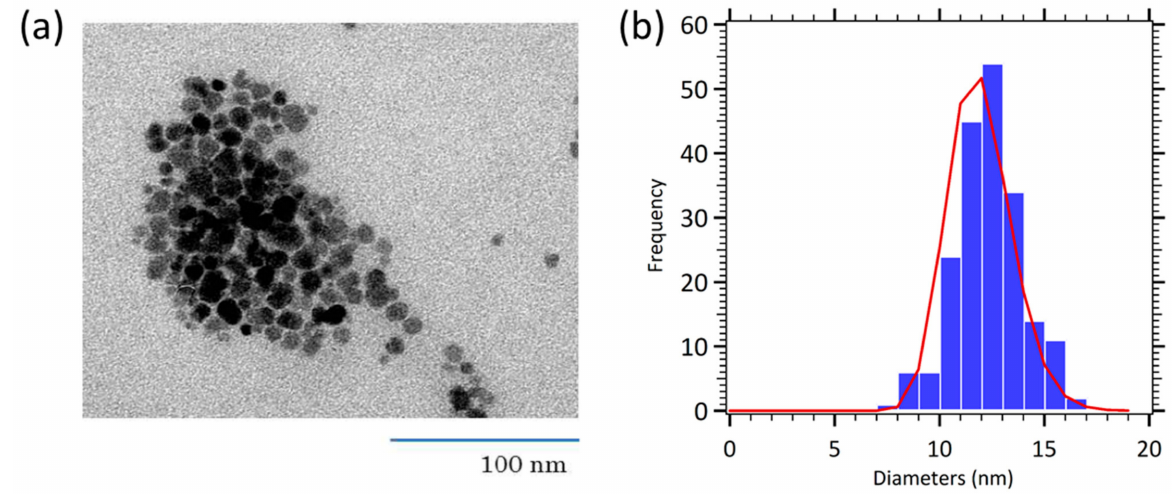
Figure A1. TEM image ( a ) and size distribution ( b ) of size sorted γ -Fe 2 O 3